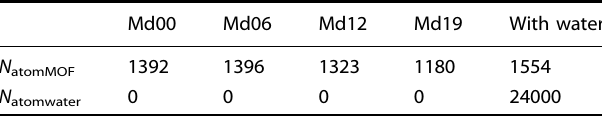
Table 1. Number of atoms in PdTCPP-Cu 2D model systems Mdxx of different degree of